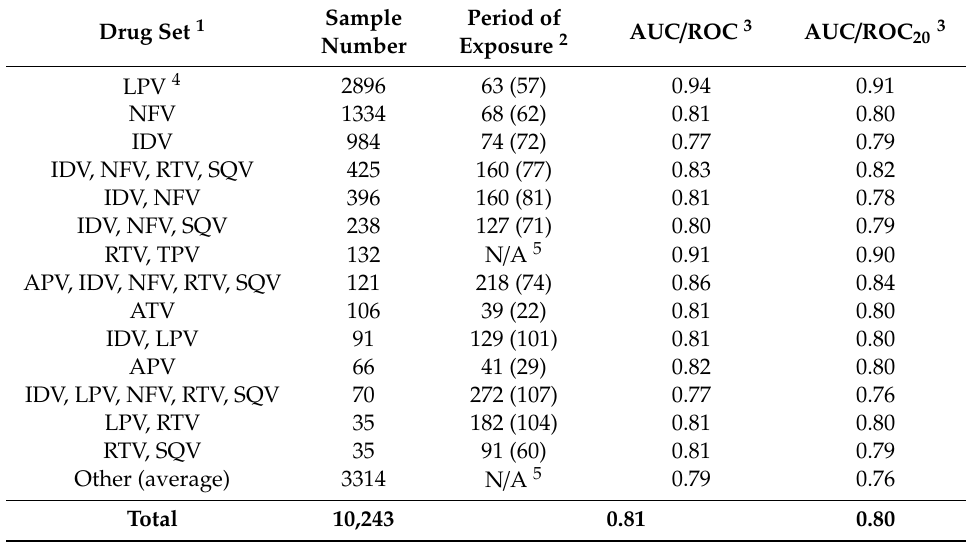
Table 1. Results of the classification of Human Immunodeficiency Virus Type 1 (HIV-1) Protease (PR) sequences according to exposure to HIV-1 PR